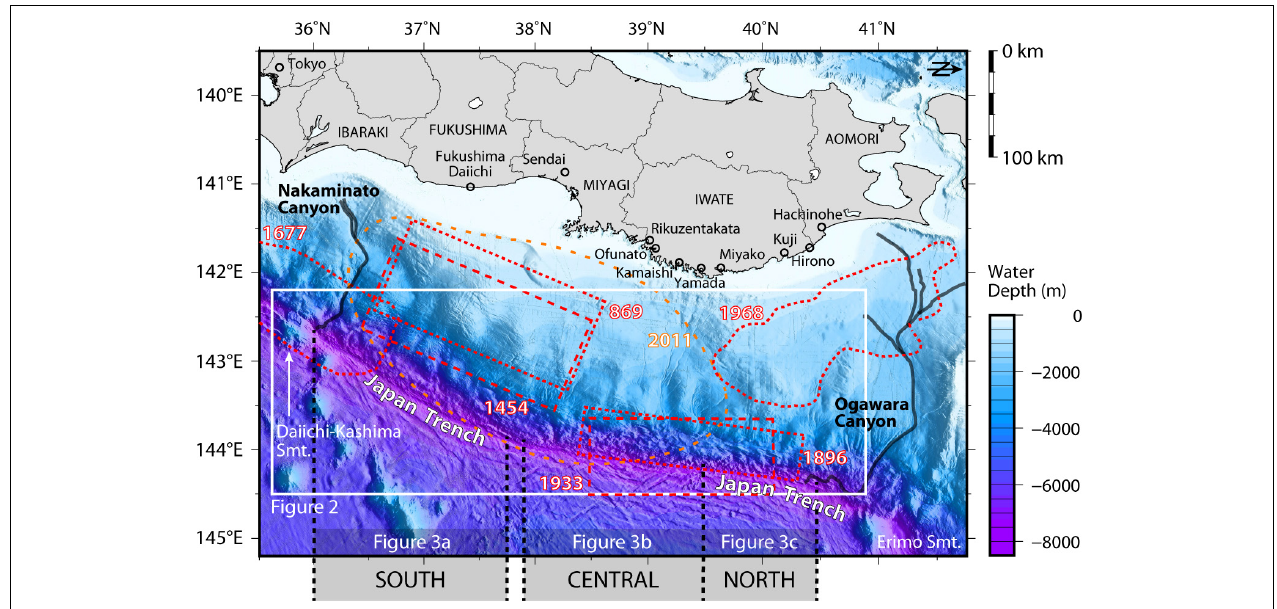
FIGURE 1 | Map of Japan Trench with historically known large earthquakes. Source areas of the earthquakes (red dash lines) are derived from literature: AD 1968 M w 8.2–8.3 Tokachi-oki (Sanriku-oki Hokubu) earthquake (Nagai et al., 2001); AD M w ∼ 8.4 1933 Showa Sanriku earthquake (Kanamori, 1971); AD 1896 M w 8.0–8.4 Meiji Sanriku earthquake (Tanioka and Satake, 1996); AD 1677 M w 8.3–8.6 Enpo Boso-oki earthquake (Takeuchi et al., 2007; Sawai et al., 2012); AD 1454 M w > =8.4 Kyotoku earthquake (Sawai et al., 2015); AD 869 M w > =8.6 Jogan earthquake (Sawai et al., 2012). The orange dashed line represents an interred 2 m-coseismic slip of the 2011 Tohoku-oki mainshock (Sun et al., 2017). A white rectangular is a domain showing the result of flow accumulation ( Figure 2 ). Water depths and SBP images along the trench axis in the southern, central, and northern Japan Trench are shown in Figure 3